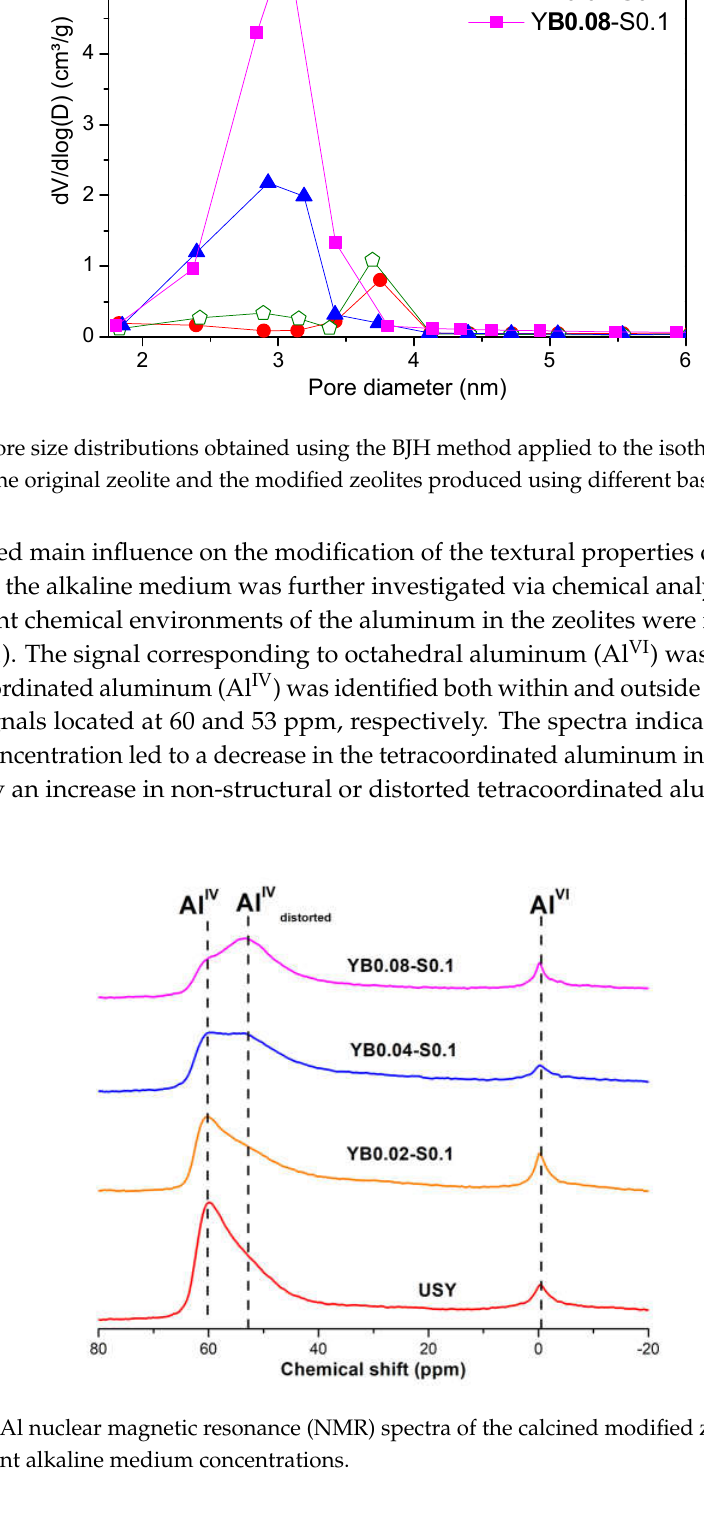
Figure 11. 27 Al nuclear magnetic resonance (NMR) spectra of the calcined modified zeolites produced using different alkaline medium concentrations.